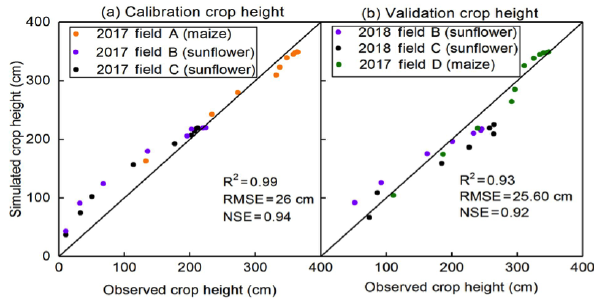
Figure 12. Comparison of predicted and observed crop height: (a) calibration and (b) validation.